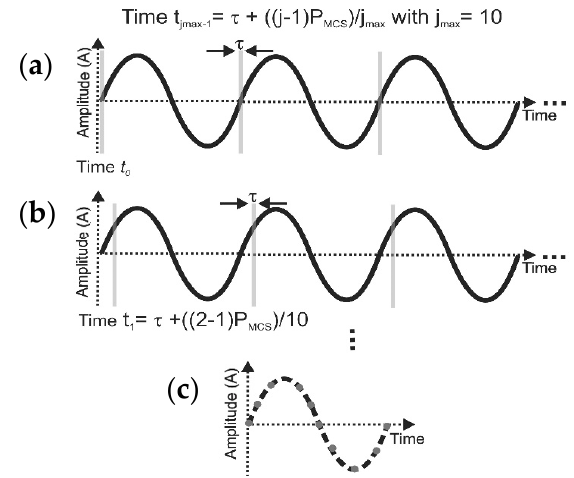
Figure 2. ( a ) As an illustrative example, three periods of a cantilever vibration are plotted in a diagram of amplitude (A) versus time. For a typical driving frequency applied to the cantilever, f MCS , the period of movement is calculated as P MCS = 1/ f MCS . ( b ) For each P MCS , the piezo-actuator excites the cantilevers periodically while a laser pulse with the pulse length time of τ = 167.5 ns is shifted in time with respect to the excitation signal to sample j max (here 10) number of different moments ( t j − 1 ). ( c ) For each moment, the signals from 2074 pulses are integrated by keeping the CCD camera shutter open (Figure 1). Finally, by fitting a sine function (dash line) to the j max = 10 desired measured moments or the so-called samples/period (dots), the vibrational amplitude for any arbitrary period is reconstructed.